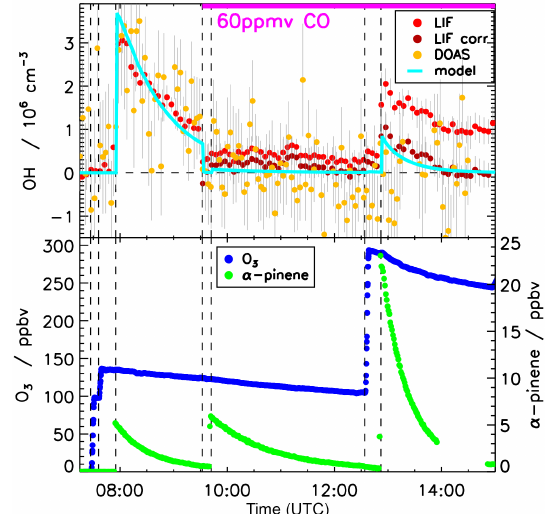
Figure 7. OH measured by LIF (cell with short inlet) and DOAS during the ozonolysis of α -pinene in dry air in the SAPHIR cham- ber with and without the presence of sufficient CO to scavenge OH. Subtraction of an offset in OH by LIF for each α -pinene oxidation period that would be an interference leads to corrected LIF data (LIF-corr) in reasonable agreement with DOAS and modelled con-